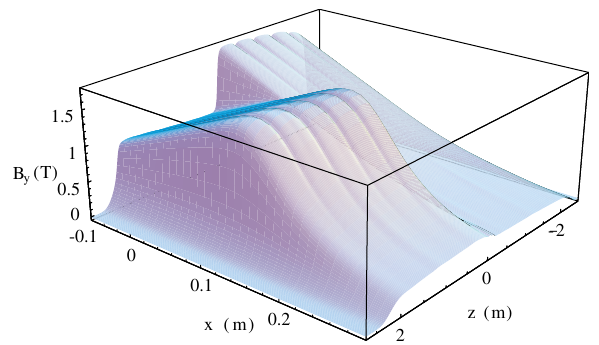
FIG. 2. (Color) Polynomial field map obtained by fit of the (cid:1) B (cid:6) x; z; 0 (cid:7) for the 26 GeV =c work- measured field values B y y ing point. Here x stands for the transverse coordinate, while z is the longitudinal one.